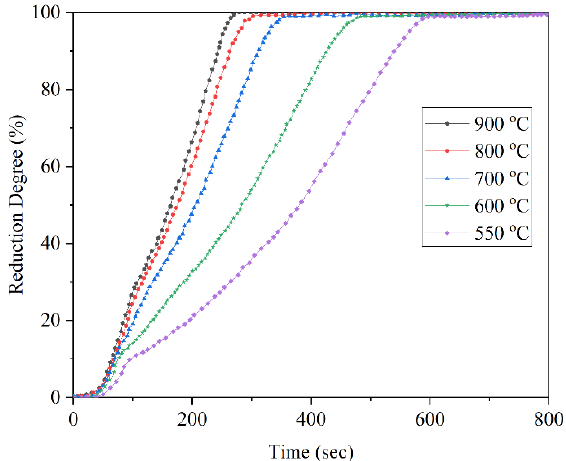
Figure 3. Effect of temperature on the reduction rate (100% H 2 ) [26]“modified”.